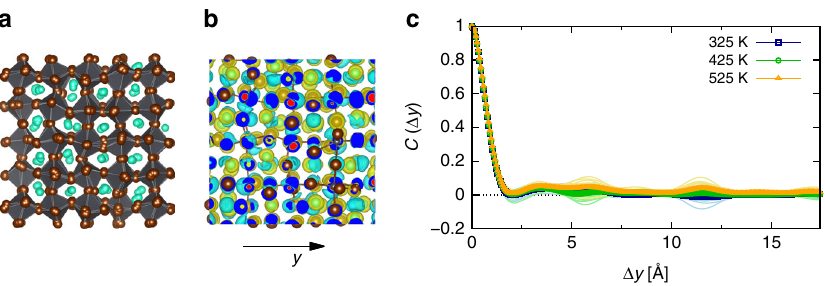
Fig. 1 Characterization of the disorder potential for electronic states in CsPbBr 3 . a Visualization of fully anharmonic dynamics in CsPbBr 3 , which include phonon-phonon interactions in the fi nite-temperature description of the dynamic distortions present in the crystal. Cs atoms are shown in cyan, Pb atoms in gray, and Br atoms in brown color; the latter two species form gray-colored octahedra. b Iso-surface representation of the charge-density difference that is induced in the crystal at an instantaneous con fi guration along the MD trajectory ( T = 425 K) with respect to the mean density. It can be seen that there is no apparent symmetric or directional response in the charge density. c Autocorrelation function of the change in the electrostatic potential energy, which represents a disorder potential for the electronic states and was calculated for the direction indicated in panel b, along the MD simulation at different temperatures. The thin curves show sample snapshots taken along the MD trajectory, and the thick curves their averages. The disorder potential in CsPbBr 3 is con fi ned dynamically to very short ranges of nearest-neighbor atomic distances